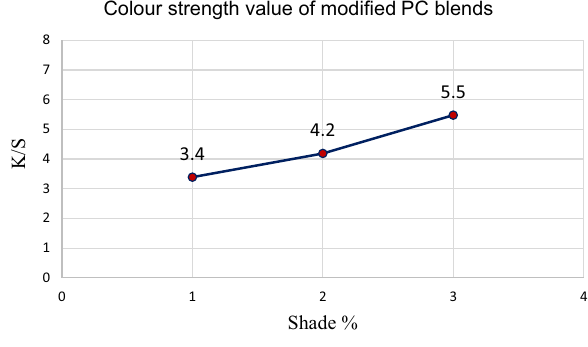
Fig. 11 K/S value of modified PC blends dyed using disperse dye in one bath at 120 °C